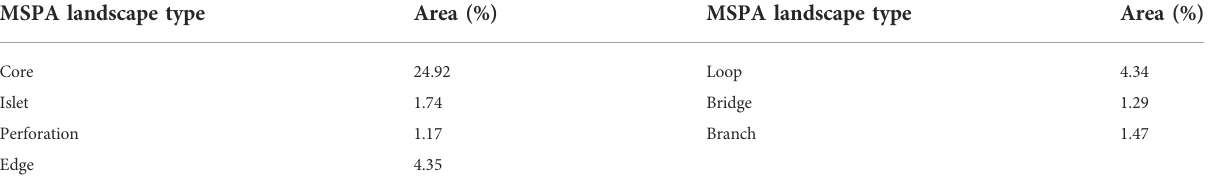
TABLE 3 MSPA landscape types and